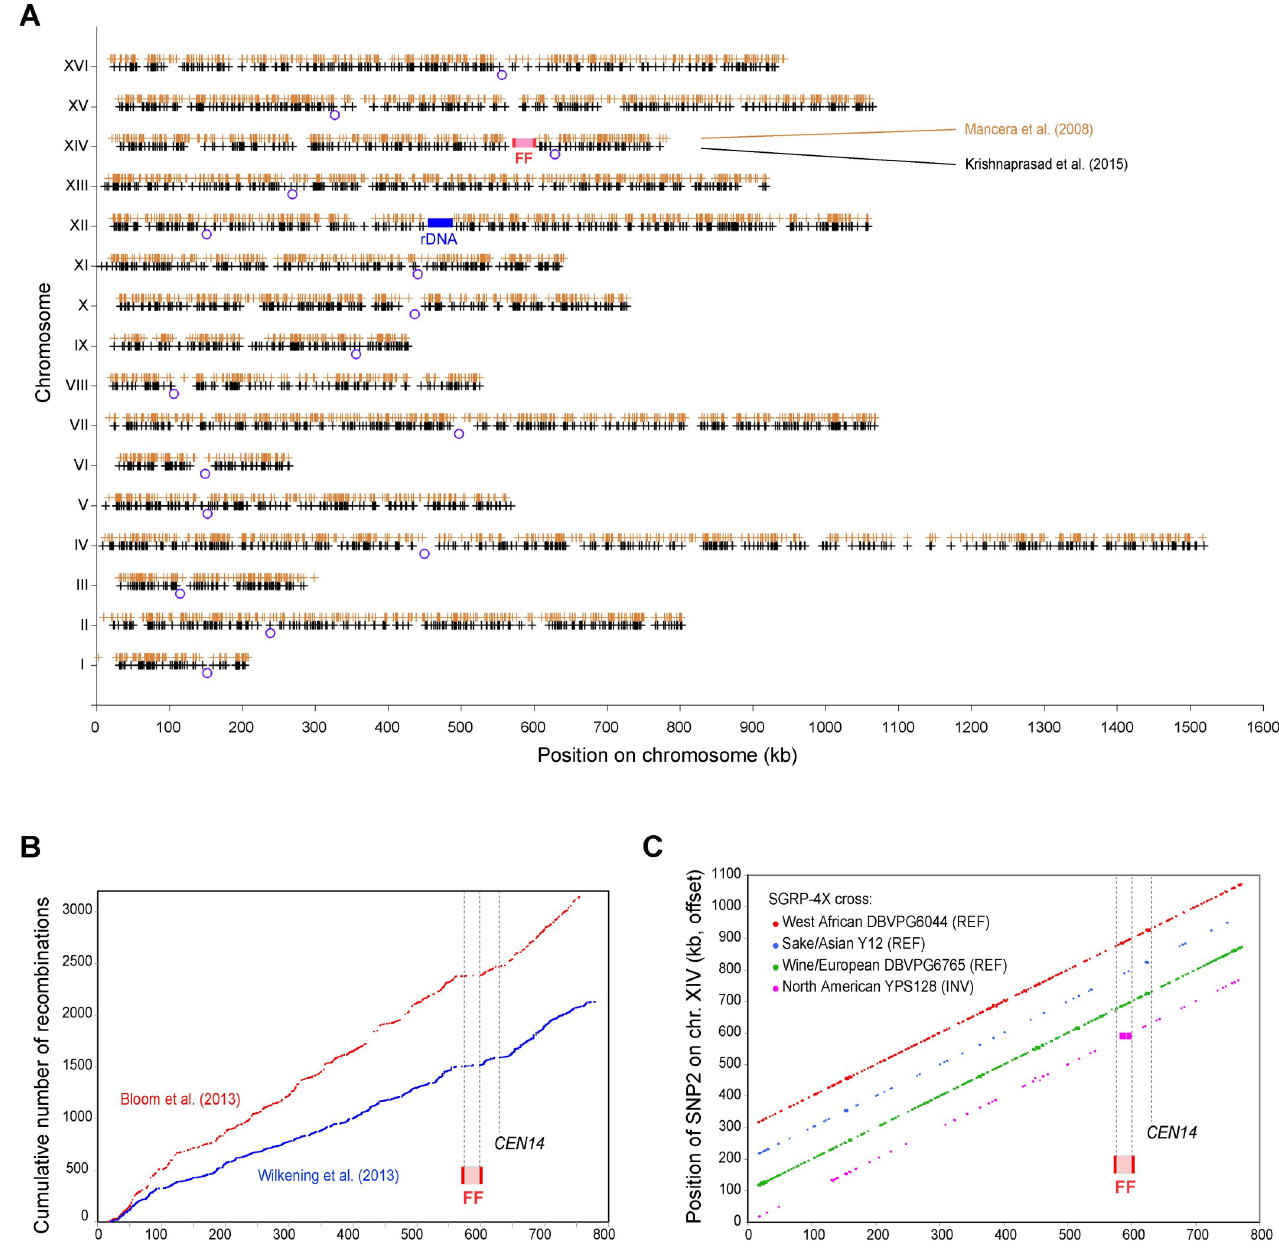
Fig 3. Meiotic recombination in the FF region is suppressed in S . cerevisiae REF x INV crosses. (A) Locations of meiotic crossovers on all chromosomes, in reanalysis of data from two S96 (REF) x YJM789 (INV) crosses. Orange crosses show the 3,235 crossovers in 50 complete tetrads from Mancera et al . [29], and black crosses show the 4,193 crossovers in 80 complete tetrads from Krishnaprasad et al . [30]. The FF (flip/flop) region on chromosome XIV is indicated in pink with the two IRs in red. Blue circles show centromere locations, and the blue rectangle marks the rDNA locus. (B) Recombination on chromosome XIV in random segregants from two REF x INV crosses: 1,008 segregants from a BY (REF) x RM (INV) cross [33] (red), and 720 segregants from an S96 (REF) x SK1 (INV) cross [31,32] (blue). The Y-axis shows the cumulative numbers of recombination events observed along chromosome XIV in each study. The FF region is seen to be a recombination coldspot. All the recombination events within it were investigated and found to be double crossovers. CEN14 is also a coldspot, like all centromeres [29]. Gaps in the lines are caused by relatively long intervals between consecutive SNP markers, in which multiple spores can show recombination and cause the cumulative total to jump. (C) Linkage disequilibrium on chromosome XIV in the SGRP-4X cross. ‘Private’ SNP alleles in each of the four parental strains used in the SGRP-4X cross were identified ( i . e ., variants that are present in one parent but absent in the other three, so they can be used as tags to identify the parental source of DNA in a segregant). Points on each of the four diagonal lines show the locations of all pairs of private SNPs (SNP1 and SNP2) from a parent that remained in complete linkage disequilibrium after 12 generations of random mating ( i . e ., the pattern of presence/absence of the